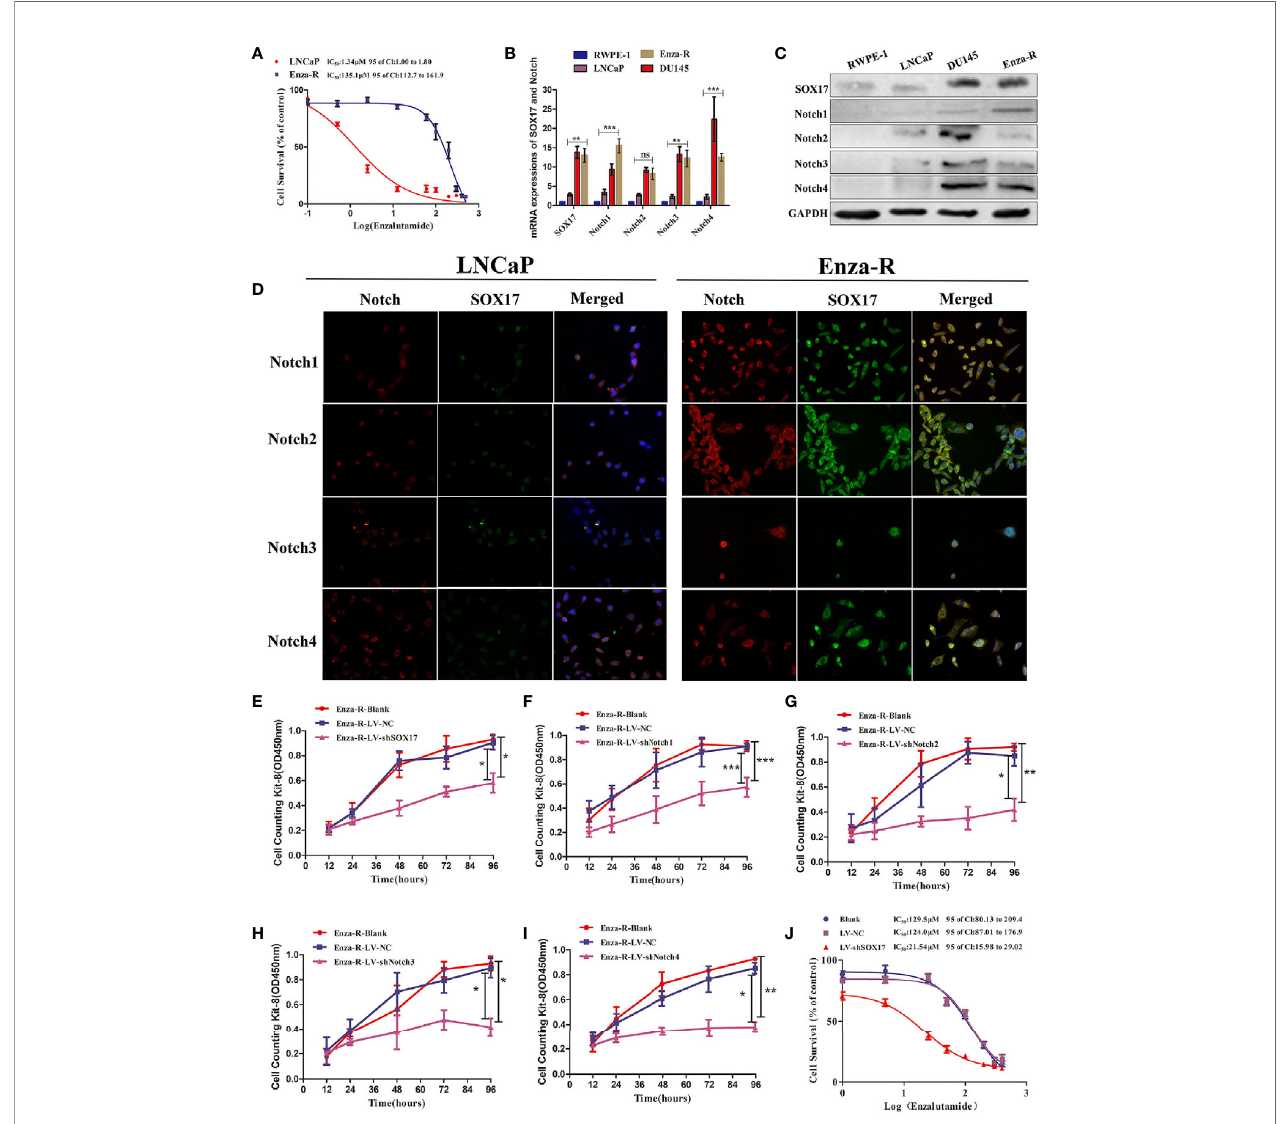
FIGURE 3 | Expression of SOX17 and Notch receptors was detected in Enza-R cells and knocking down them inhibited the viability of Enza-R cells. (A) Identi fi cation for CRPC cells, both LNCaP and Enza-R cells were treated with increasing concentrations of enzalutamide for 24 h and IC50 was detected by cell counting kit-8 (CCK-8) assay. (B – D) Expression of SOX17, Notch receptors in both mRNA and protein level was detected by RT-PCR, Western blot and Immuno fl uorescence assay (magni fi cation, ×200). (E – I) After incubated for 96 h, the viability of Enza-R cells, treated with shSOX17, shNotch1, shNotch2, shNotch3, and shNotch4 respectively, was evaluated by CCK-8 assay. (J) Enza-R cells, infected with LV-NC or LV-shSOX17, were treated with increasing concentrations of enzalutamide for 24 h, and the half maximal inhibitory concentration (IC50) was determined by CCK-8 assay. Enza-R: enzalutamide-resistant LNCaP cells. *P < 0.05, **P < 0.01, ***P < 0.001, ns, no signi fi